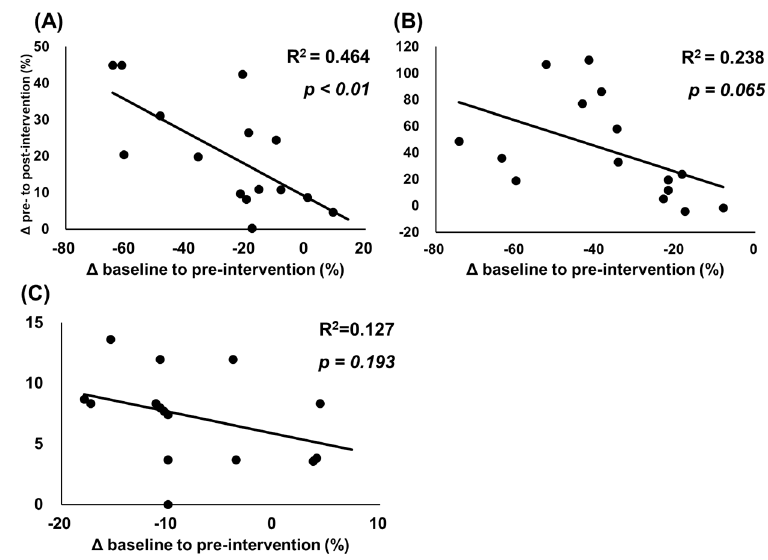
Figure 4. Relationships between relative changes in muscle strength and range of motion. Data presented as individual data points with R 2 and p values. The figure shows relationships between relative changes (%) from baseline to pre-intervention and from pre-intervention to post-intervention in maximal voluntary isometric contraction ( A ), maximum voluntary concentric contraction of the knee extensors ( B ), and passive knee flexion range of motion ( C ).